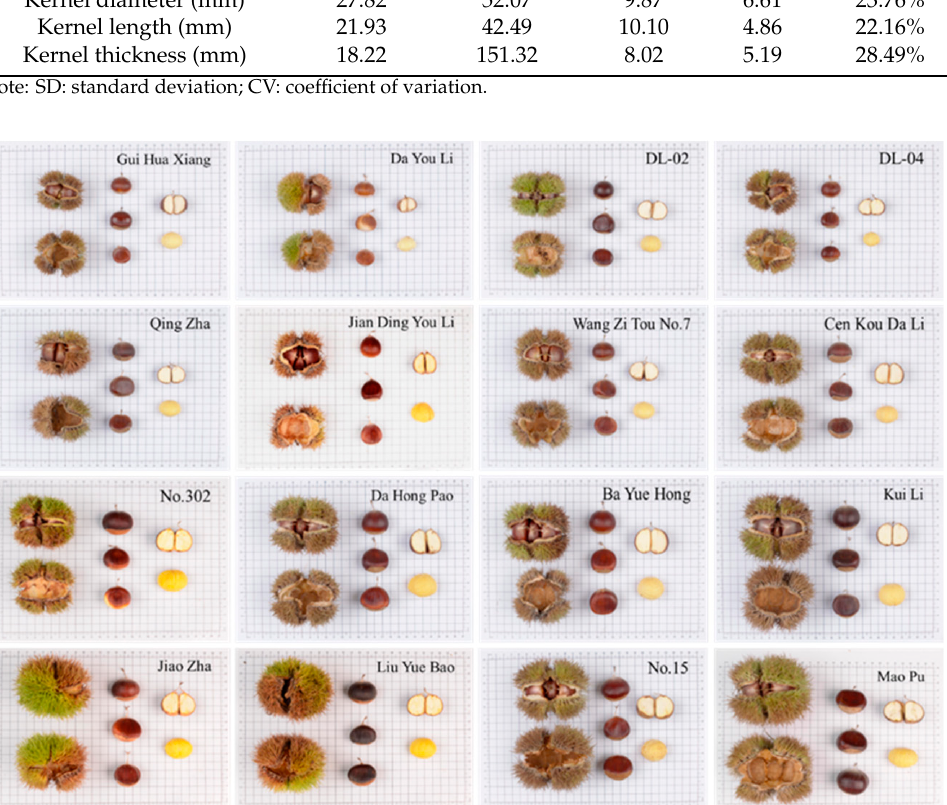
Figure 2. Cone seed atlas of di ff erent cultivars of the Castanea germplasm resources.